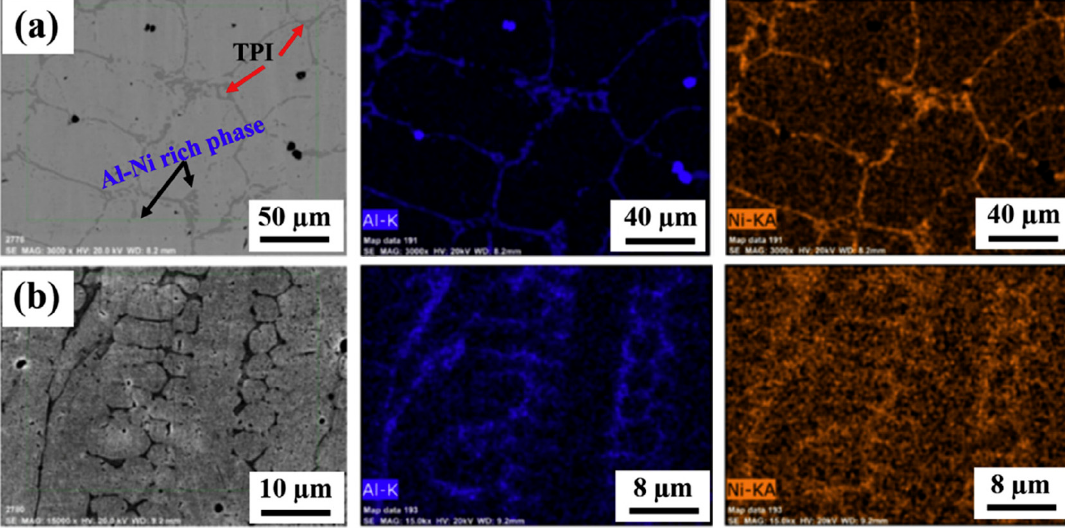
Figure 3. Comparison of the microstructure of the ( a ) BM and ( b ) WZ of Al 0.5 CoCrFeNi HEA. Inset of EDX mapping of Al and Ni of both regions. Adapted from [27].